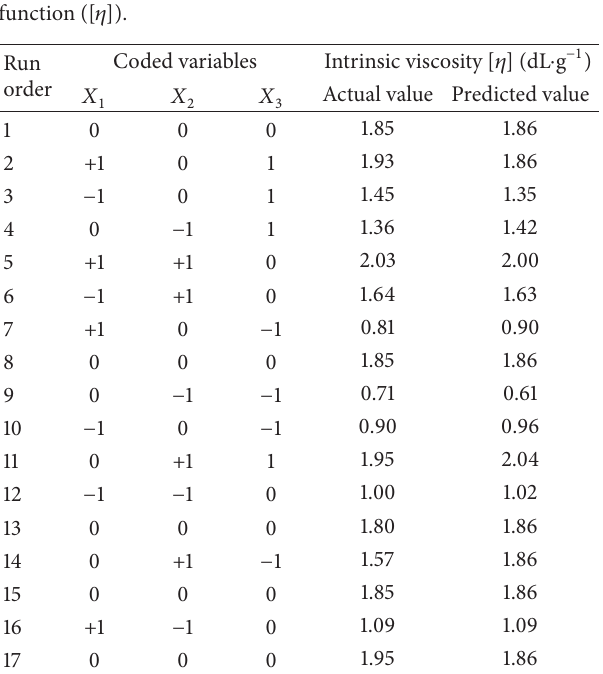
Table 2: 3-Factor Box-Behnken design and the value of response function ( [𝜂]